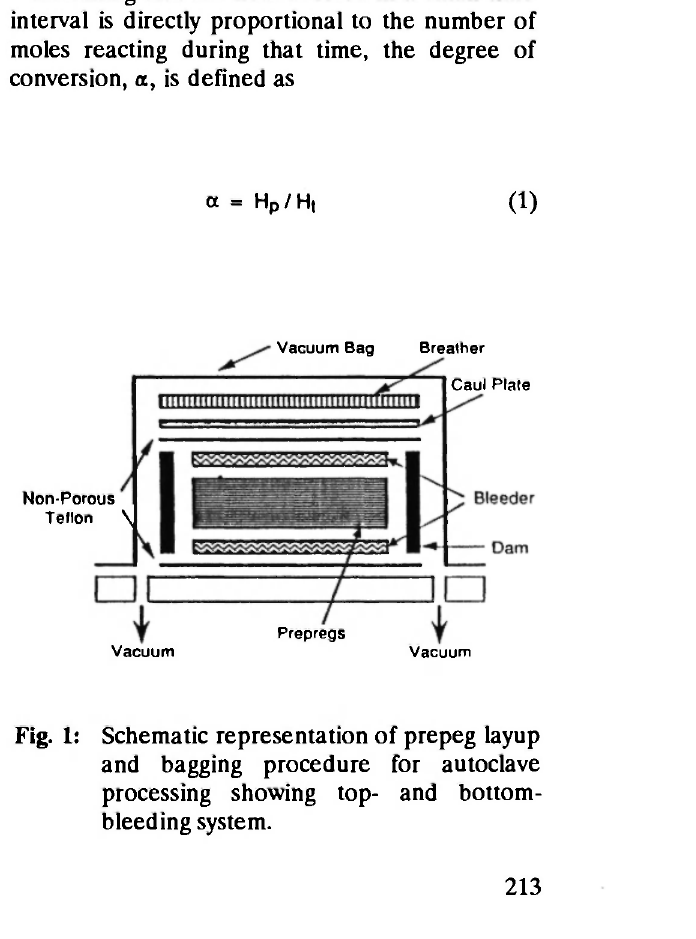
Fig. 1: Schematic representation of prepeg layup and bagging procedure for autoclave processing showing top- and bottom- bleeding